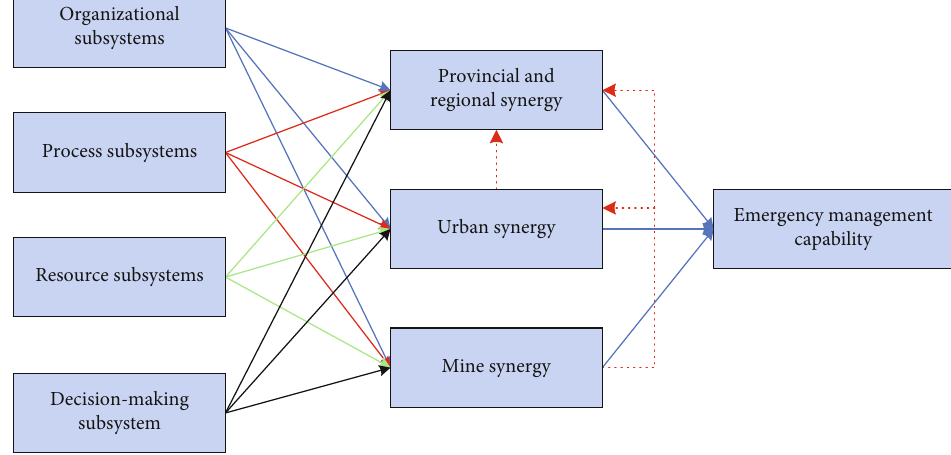
Figure 1: Mechanism of regional CME management